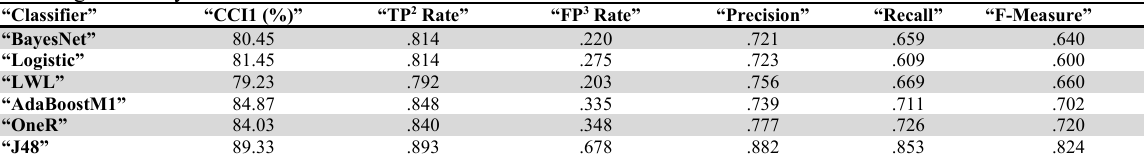
Predicting the PU by PP and PEOU “Classifier”